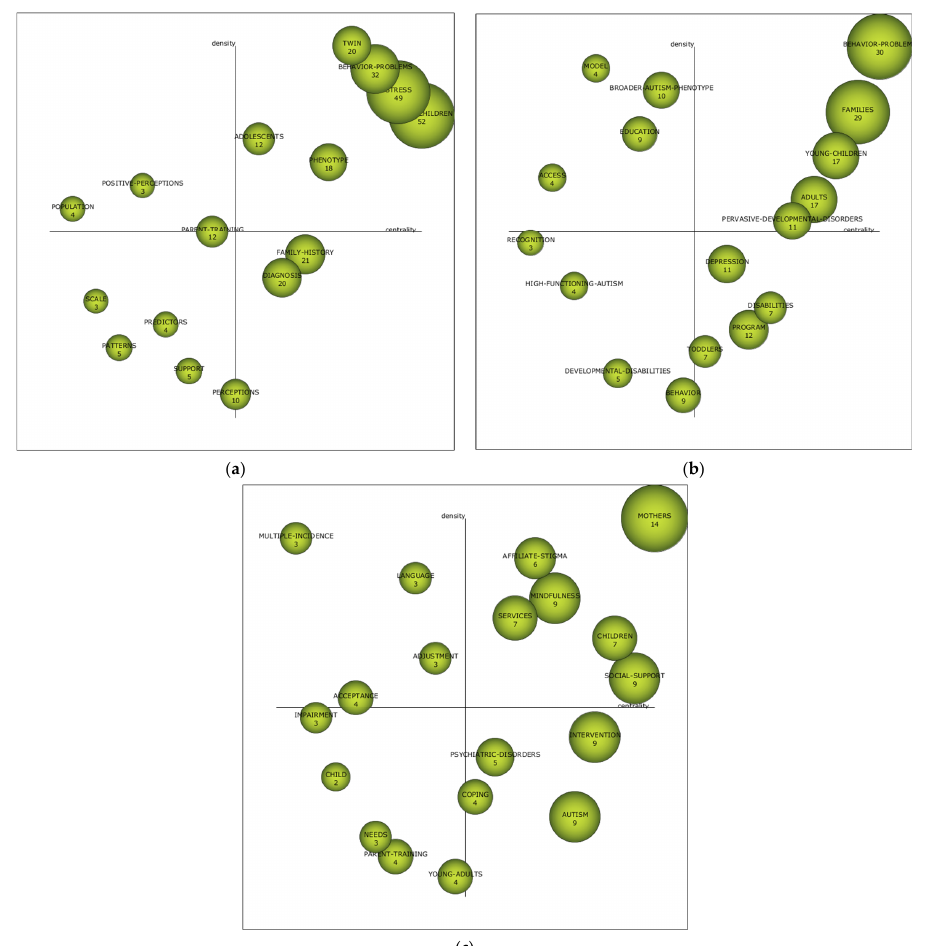
Figure 4. Strategic diagram per ASD-PAR index-h. Note: ( a ) Interval 1971–2012; ( b ) Interval 2013–2016; ( c ) Interval 2017–2019. In the first period (1971–2012), the driving themes are “adolescents”, which are re- lated to “adults”, “depressed-Mood”, “expressed-emotion”, “quality”, “validity”, “relia- bility”, “schizophrenia” and “symptoms”; “phenotype, which relates to “brain”, “defi- cits”, “disorders”, “personality-characteristics”, “pervasive-developmental-disorders”, “psychiatric-disorders”, and “weak-central-coherence”; “twin”, which relates to “broad- autism-phenotype”, “children”, “genetics”, “history”, “individuals”“infantile-autism”, “personality” and “traits”; “behavior-problems”, which relates to “fathers”, “family- stress”, “intellectual-disability”, “maternal-stress”, “mental-health”, “parenting-stress”,